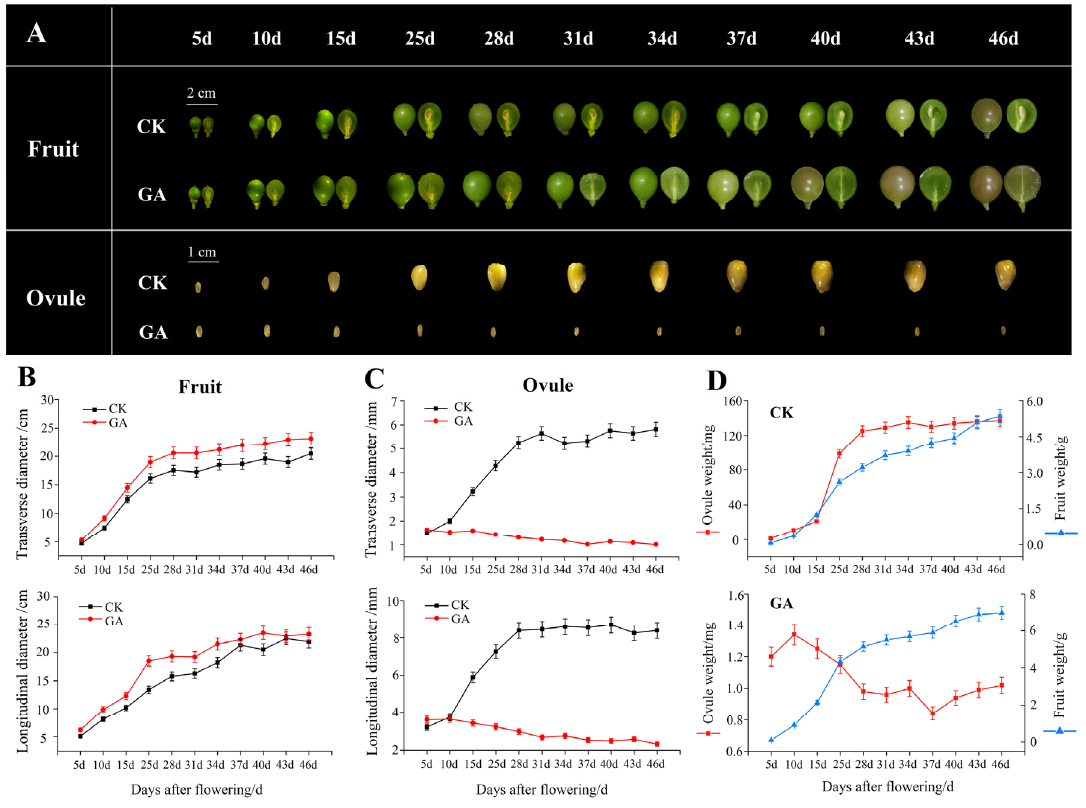
Figure 1. Morphological changes of grape berries and embryos after GA treatment. The appearance of grape and ovule changed after exogenous GA treatment. The appearance of the berry and ovule ( A ), the changes in the transverse and longitudinal diameter of berries ( B ), changes in transverse and longitudinal diameters of ovules ( C ), and changes in berry and ovule weight per grain ( D ) in response to GA exogenous. d in horizontal axes represents days after grape